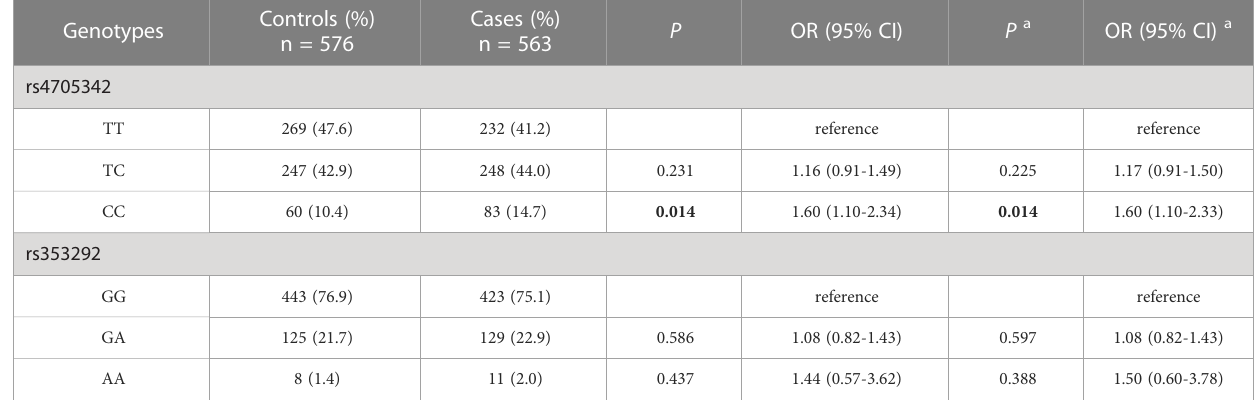
TABLE 1 Association of rs4705342 and rs353292 polymorphisms with the risk of epithelial ovarian cancer.